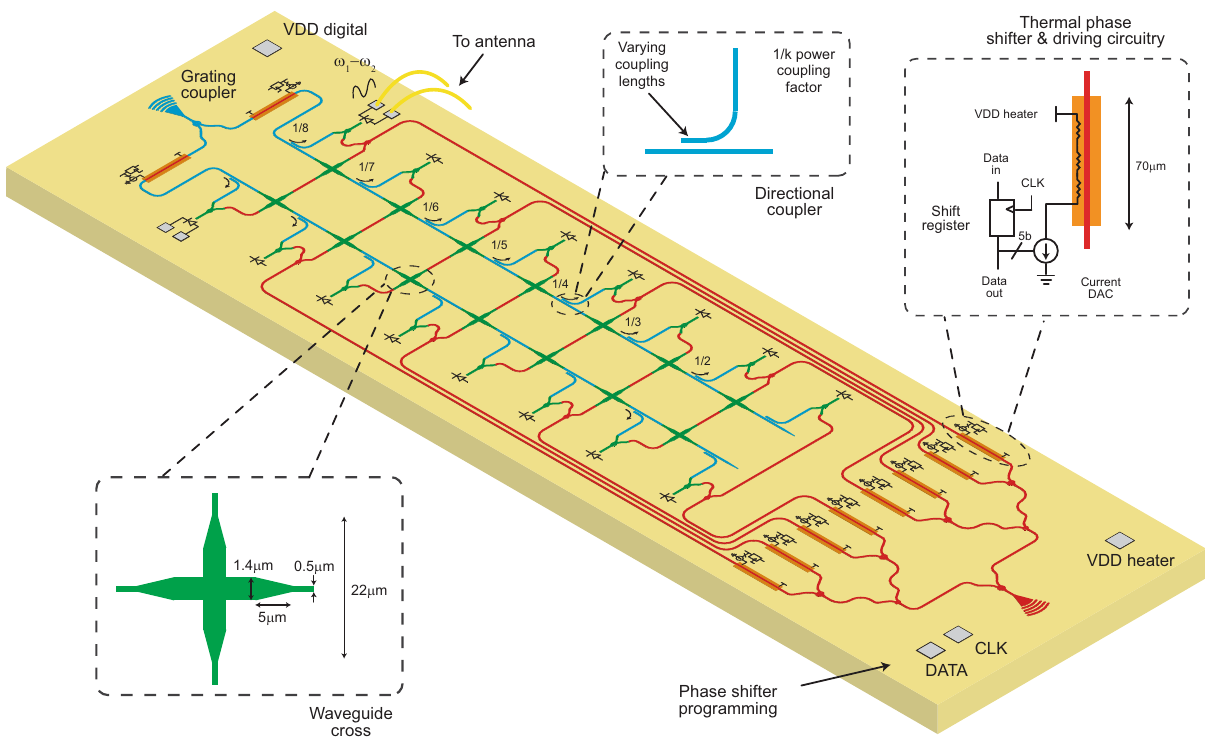
Fig. 2 | Integrated electronic-photonic phased array transmitter chip. Archi- tecture of the 2×8 photonic - assisted mm-wave phased array transmitter chip fabricated in GlobalFoundries 90nm CMOS 9WG process. The transistor level